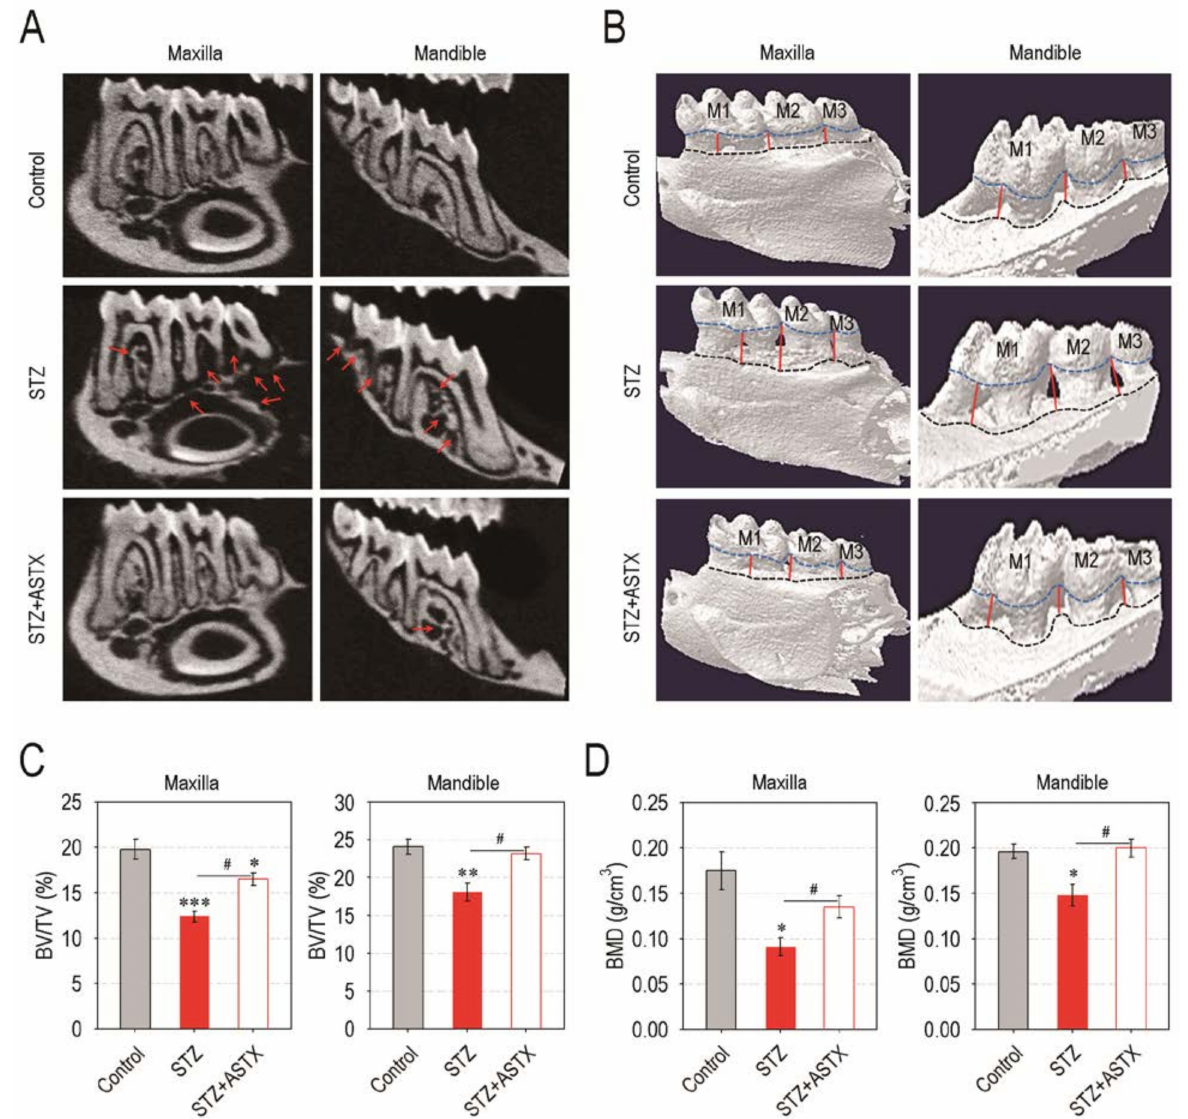
Figure 2. Supplemental ASTX restores hyperglycemia-triggered destruction of alveolar bone in STZ-induced diabetic mice. ( A ) Representative 2D µ CT images showing alveolar bone around the molars in the maxilla and the mandible 60 days after hyperglycemia induction. The red arrows indicate the resorbed alveolar bones around the upper and lower molars. A representative result from five different samples is shown. ( B ) The reconstructed 3D µ CT images of the maxilla and the mandible. In 3D images, blue and black dash lines indicate CEJ and ABC, respectively, while red lines represent a boundary of resorbed alveolar bone in the lower and upper molar regions. ( C ) The values of bone volume/tissue volume (BV/TV, %) and ( D ) bone mineral density (BMD, g/cm 3 ) in the maxilla and the mandible were calculated from the µ CT images ( n = 5). * p < 0.05, ** p < 0.01, and *** p < 0.001 vs. control group; # p < 0.05 vs. STZ